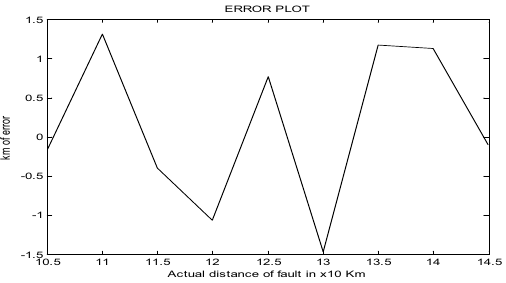
Fig. 5(e)(ii). Fault location error of Hybrid approach for double line to ground fault